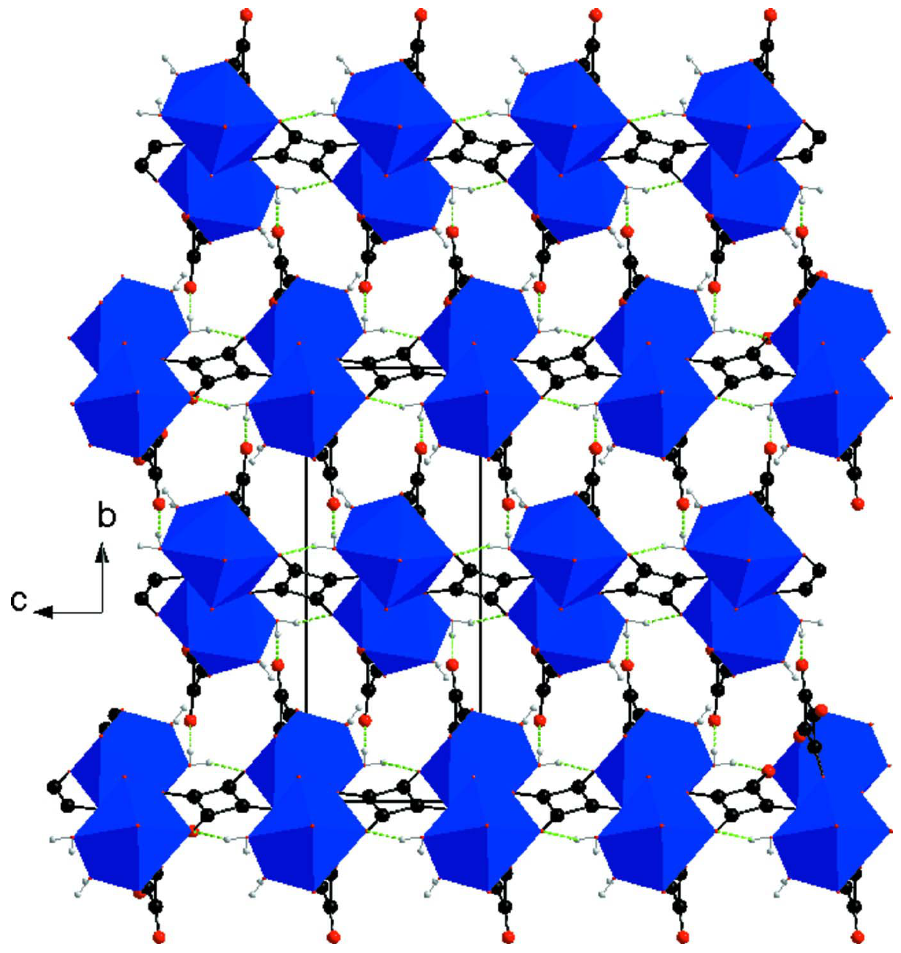
Figure 2 A diagram of the layered crystal packing in the unit cell of (I). Hydrogen bonds are shown as green dashed lines. Poly[tetraaqua- µ -squarato-di- µ 4 3